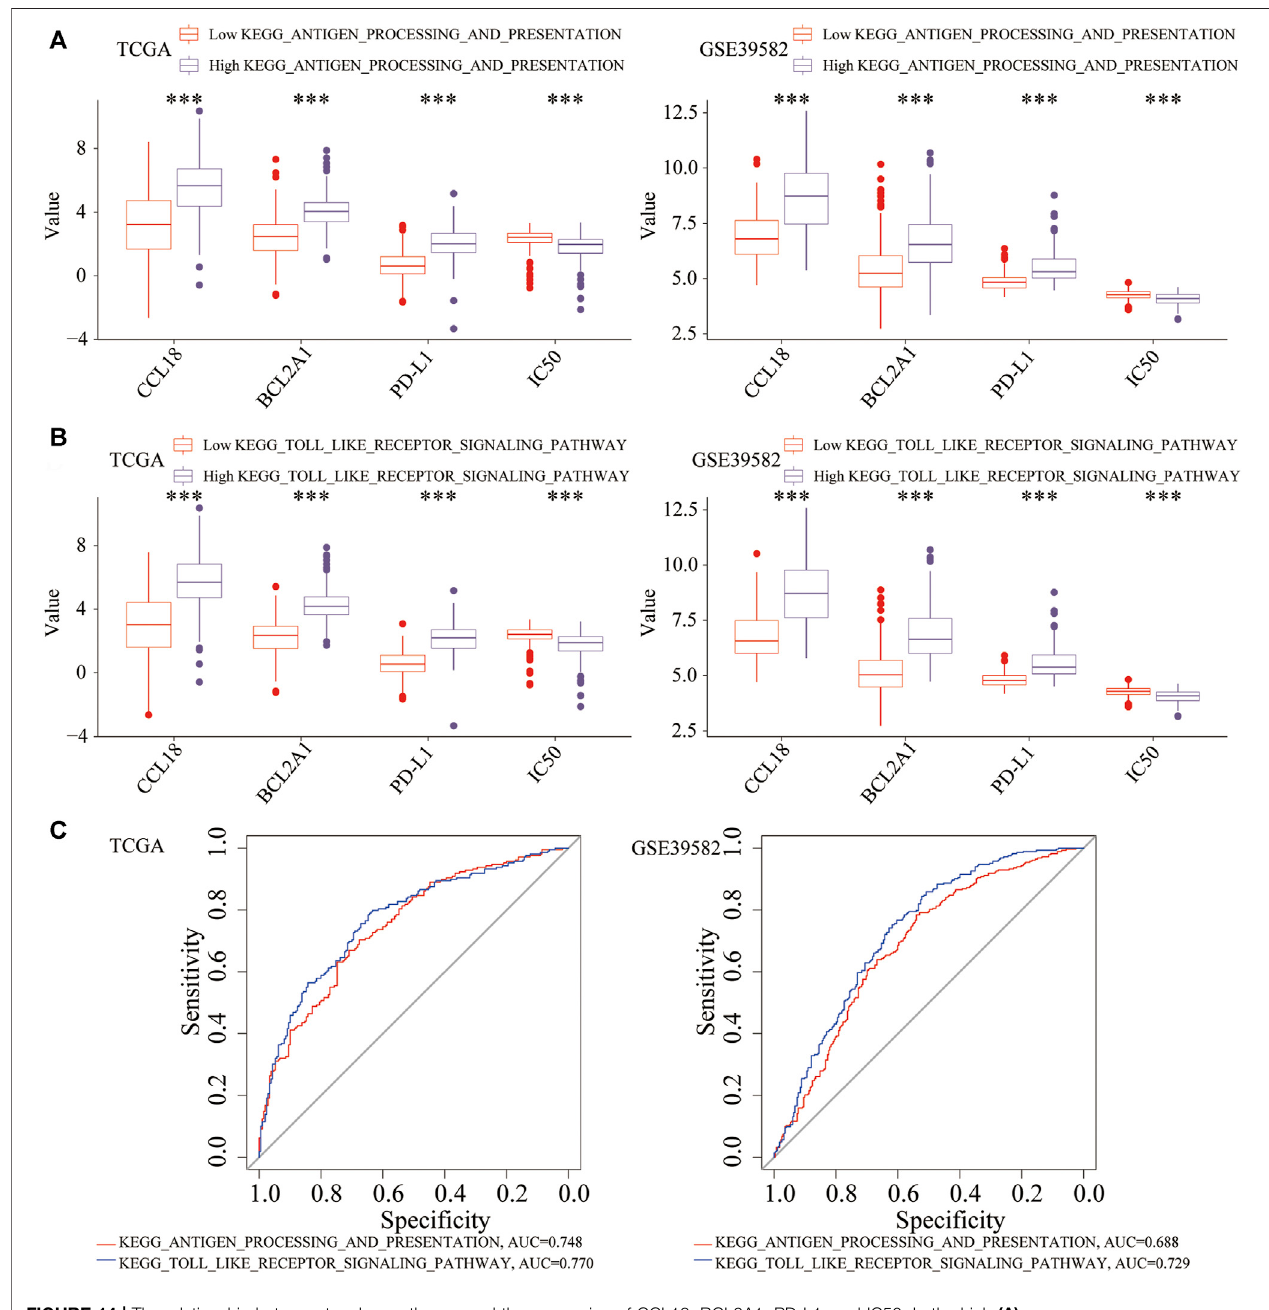
FIGURE 14 | The relationship between two key pathways and the expression of CCL18, BCL2A1, PD-L1, and IC50. In the high (A) KEGG_ANTIGEN_PROCESSING_AND_PRESENTATION or (B) KEGG_TOLL_LIKE_RECEPTOR_SIGNALING_PATHWAY group, CCL18, BCL2A1 and PD-L1 were signi fi cantly upregulated, and the IC50 was signi fi cantly downregulated. (C) Diagnostic ef fi cacy of the two pathways (high vs. low IC50). *** p < .001.